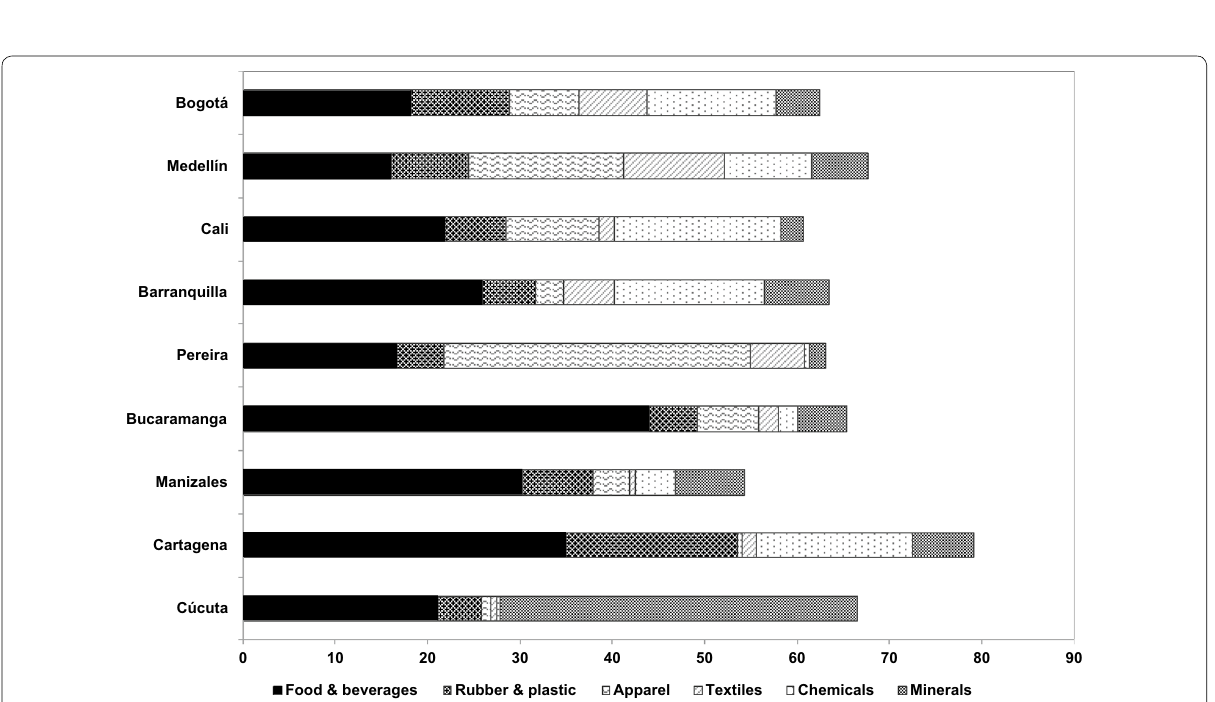
Fig. 2 Employment generation by subsector and city, 2013 ( Source Dane-AMS and authors’